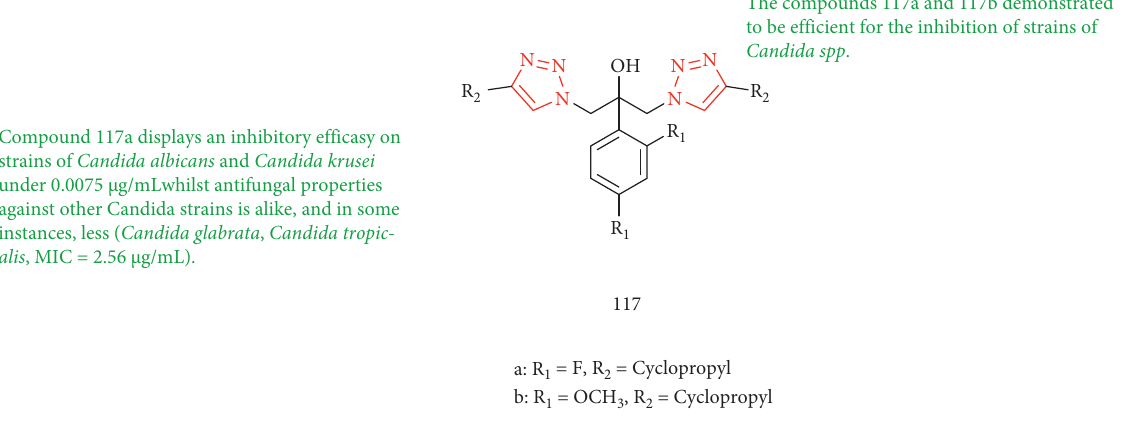
Figure 56: Chemical structure of 1,3- bis -(1,2,3-triazol-1-yl)-propan-2-ol derivatives.